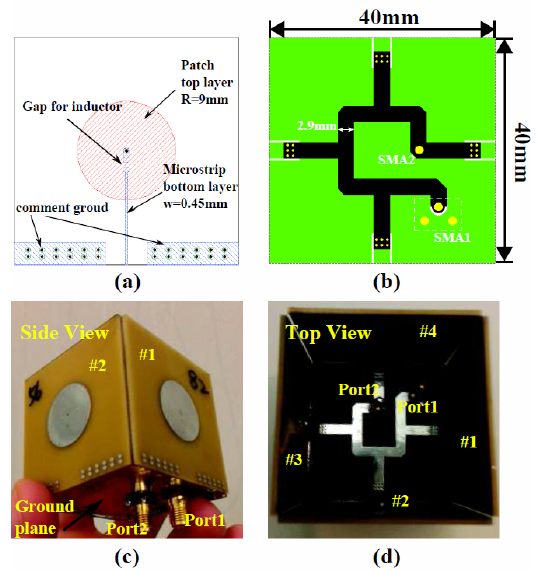
Figure 4. The designed layout and the fabricated sensor. ( a ) The layout of the sensor element; ( b ) the layout of the feeding network, with the top layer shown in black and the bottom layer shown in green; ( c , d ) pictures of the fabricated